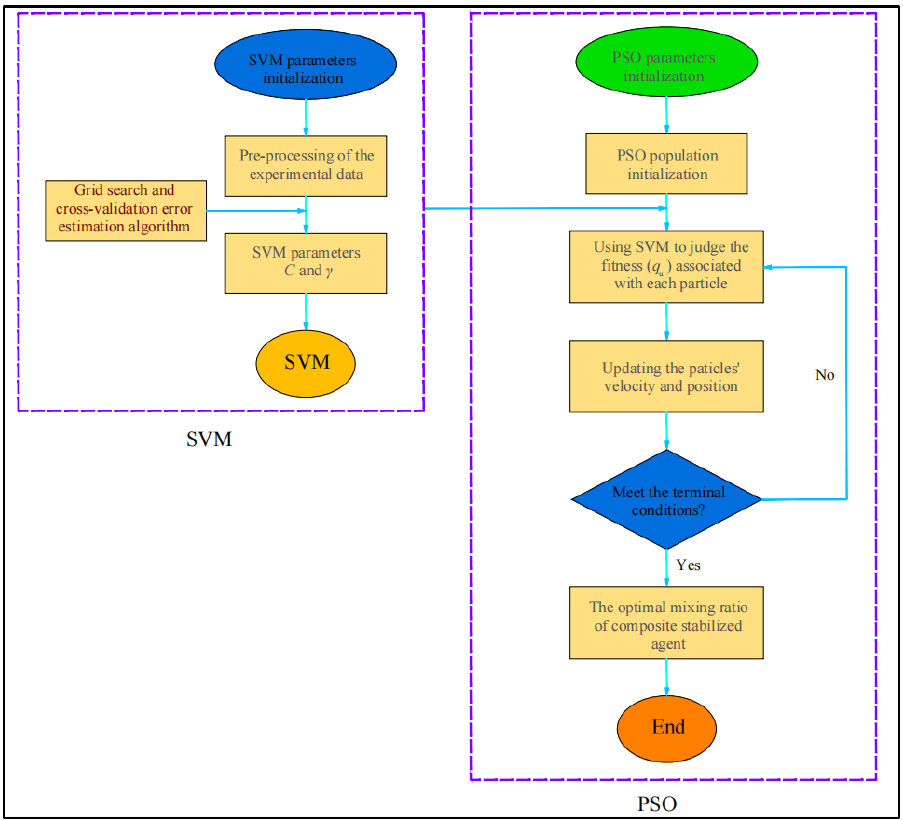
Figure 8. Flow chart of PSO–SVM for the optimal mixture ratio of the composite curing agent [37] (Reproduced with permission from Jianfeng Zhu, [Construction and building materials]; published by [ELSEVIER SCI LTD], [2022]).